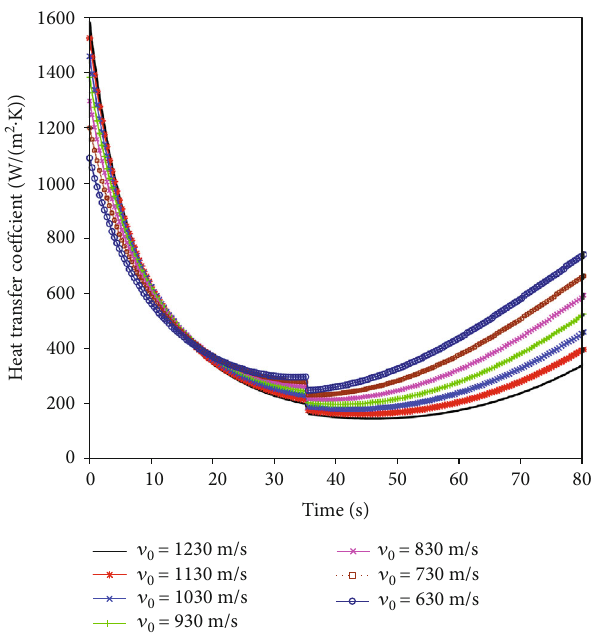
Figure 10: Average coe ffi cients at di ff erent launch